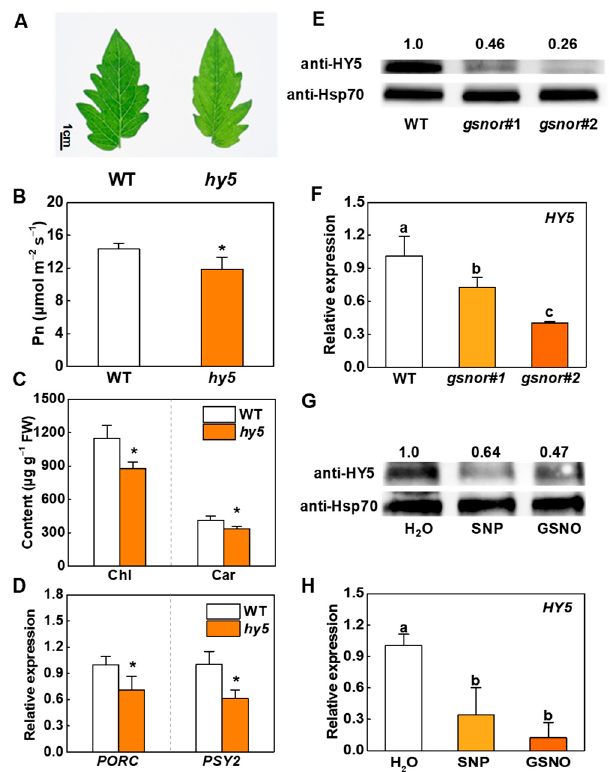
Figure 3. HY5 is required for NO-regulated plant photosynthetic pigment biosynthesis. ( A ) Leaf phenotypes displayed for WT and hy5 . Bar represents 1 cm. ( B ) Pn, ( C ) chlorophyll and carotenoid content of leaves, and ( D ) relative transcript levels of PORC and PSY2 in WT and hy5 . ( E , F ) HY5 accumulation and relative transcript levels of (ELONGATED HYPOCOTYL5) HY5 in WT, gsnor#1 , and gsnor#2 . ( G , H ) The effects of SNP and GSNO on HY5 accumulation and relative transcript levels of HY5 . Data are shown as means ± SD ( n = 3). For ( B – D ), asterisks indicate statistically significant differences from the control (WT) with respect to the means (*, p < 0.05). For ( F , H ), different letters